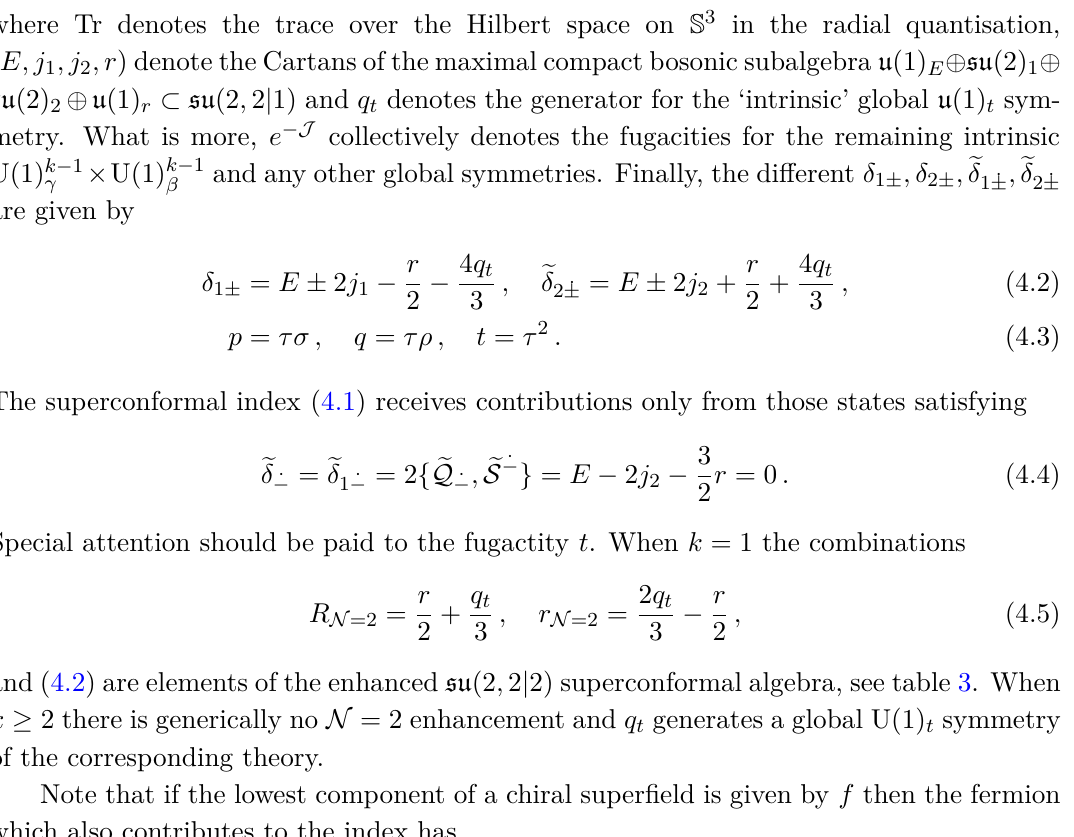
and projects out any supercharge with q t